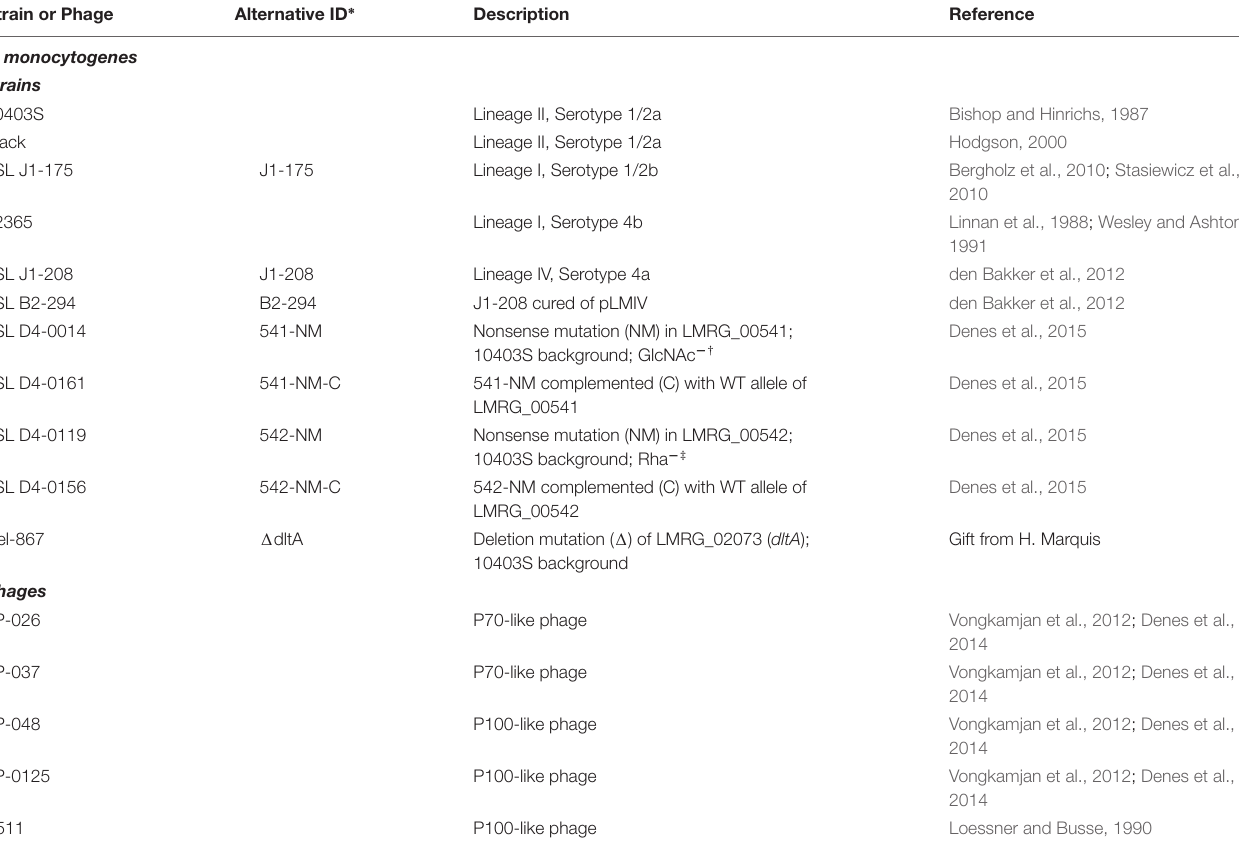
TABLE 1 | Phages and bacterial strains used in